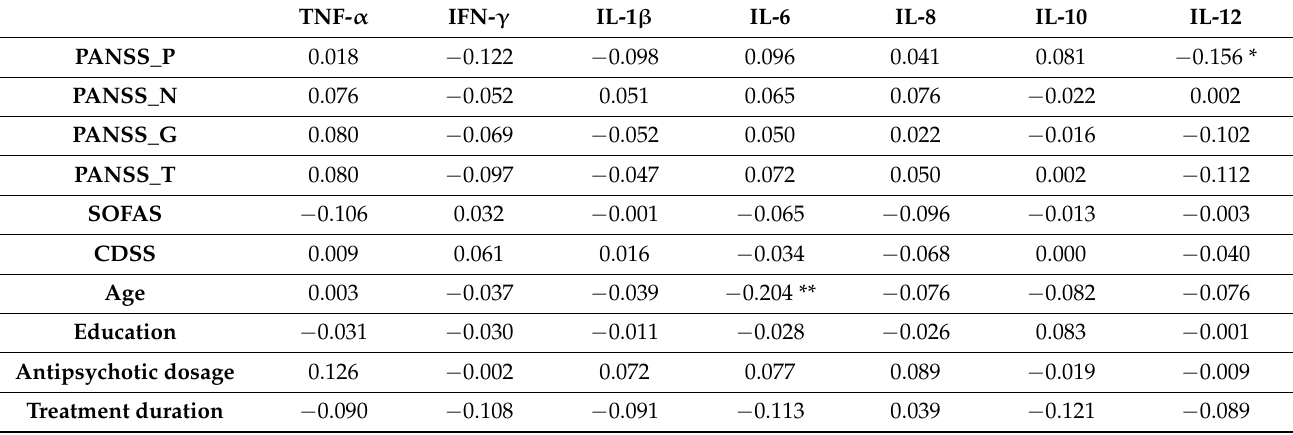
Table 2. Spearman correlation coefficients between cytokines and clinical measures.